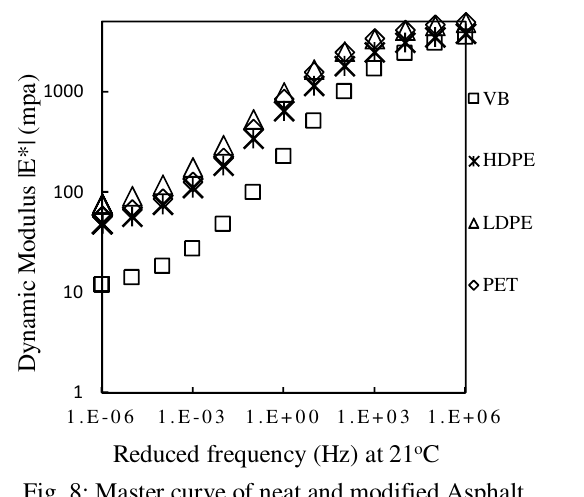
Fig. 8: Master curve of neat and modified Asphalt mixes